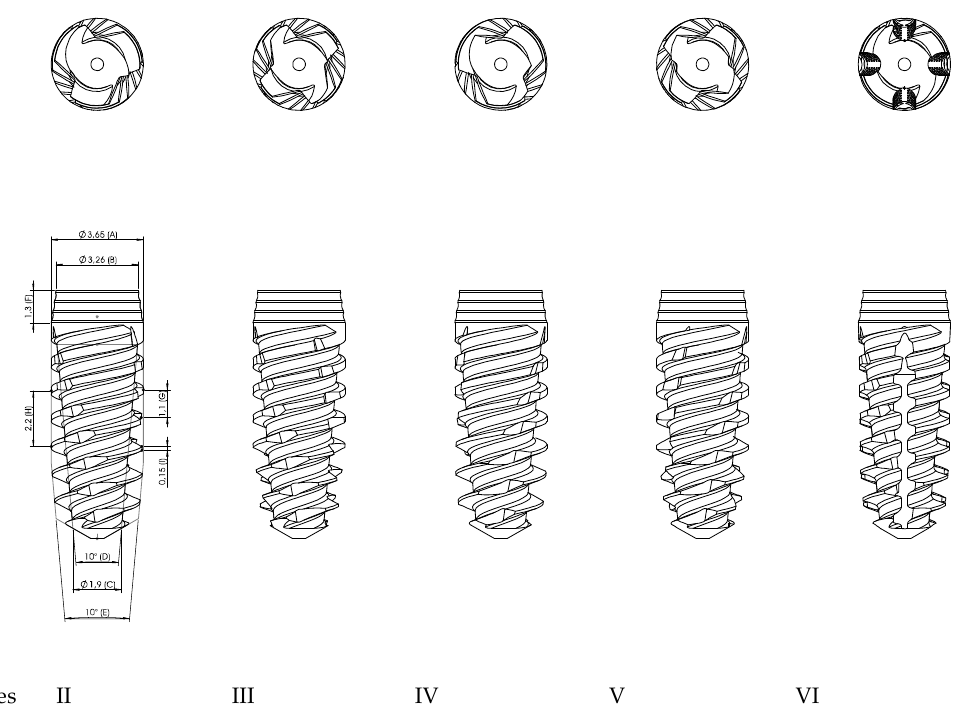
Figure 3. Prototypes II, III, IV, V, and VI with di ff erent vertical grooves in di ff erent numbers and